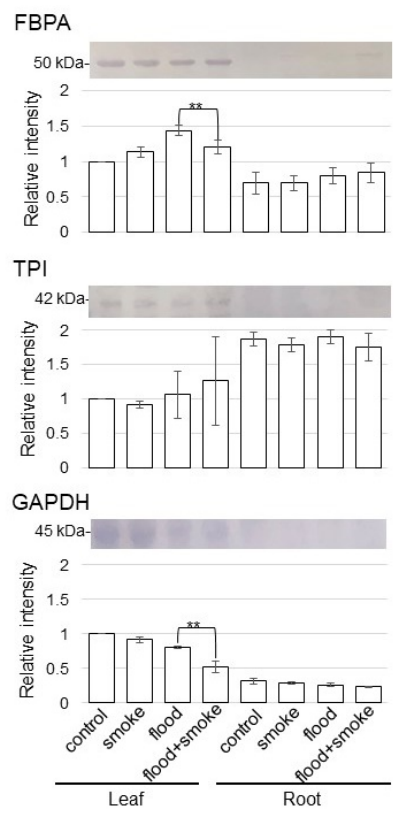
Figure 7. Immunoblot analysis of the proteins involved in glycolysis in wheat treated with the plant-derived smoke solution under flooding stress. Proteins extracted from the leaves and roots of wheat seedlings were separated on SDS-polyacrylamide gel by electrophoresis and transferred onto membranes. The membranes were cross-reacted with anti-FBPA, TPI, and GAPDH antibodies. A staining pattern with Coomassie-brilliant blue was used as a loading control (Figure S1). The integrated densities of bands were calculated using ImageJ software. The data are presented as mean ± SD from 3 independent biological replicates (Figures S3–S5). Asterisks indicate significant changes in the relative intensity of the signal band in the plant-derived smoke solution under flooding compared to only flooding according to the Student’s t -test (**: p < 0.01).